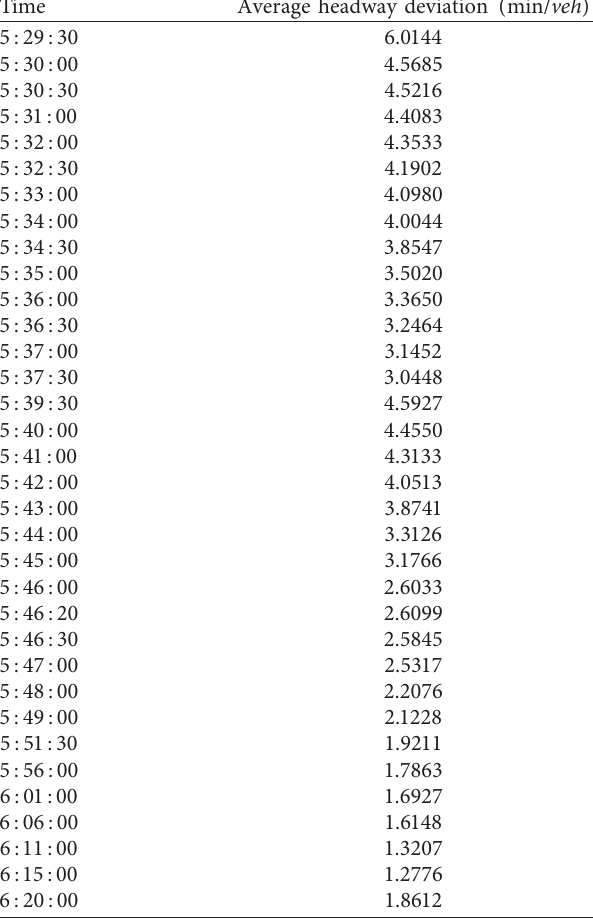
Table 6: Simulation output results under the whole system control strategy.